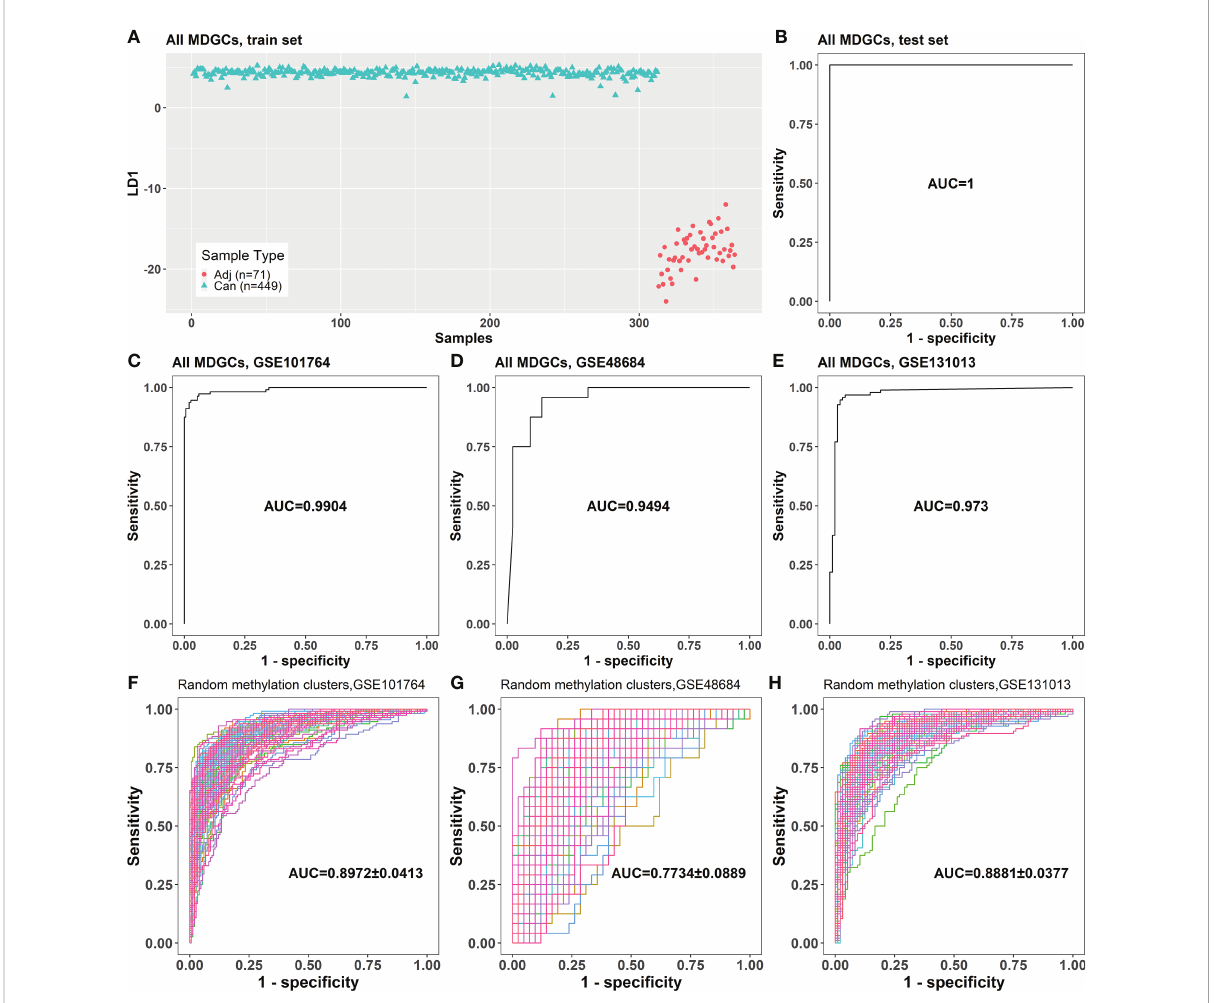
FIGURE 2 The classi fi cation performance of the LDA model based on 752 MDGs. (A) The LDA model established with the samples in the train set. (B) The classi fi cation performance of the LDA model on the test set. (C – E) The classi fi cation performances of the LDA model for cancer and cancer- adjacent samples from GSE101764, GSE48684, and GSE131013. (F – H) The classi fi cation performances of the LDA models based on randomly selected 761 genes on GSE101764, GSE48684, and GSE131013 datasets (100 repeats). Adj, cancer-adjacent tissues; Can, cancer tissues; LDA, linear discriminant analysis; MDGs, methylation-driven